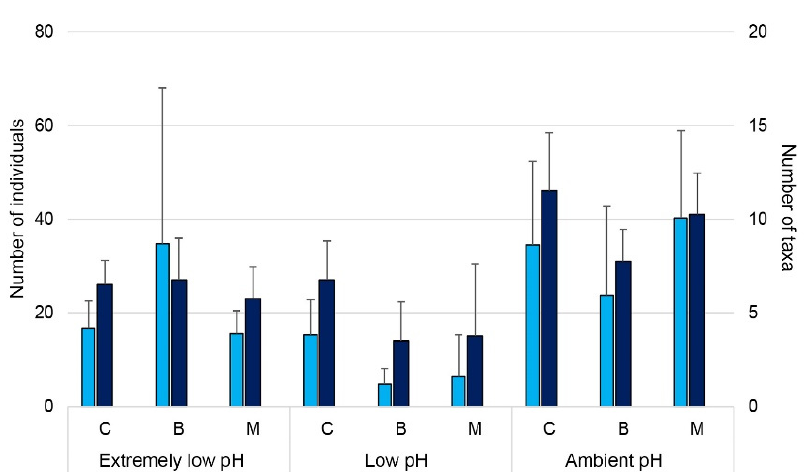
Figure 4. Mean value of number of individuals (cyan) and mean number of taxa (dark blue) with SD bars in the three pH conditions, and microhabitats within the meadow (C = canopy; B = bottom, M = dead matte) at the Vu site. Table 5. Output of the GLMs fitted to the number of taxa and number of individuals in the three microhabitats at the Vu site. Significant values are highlighted in bold.